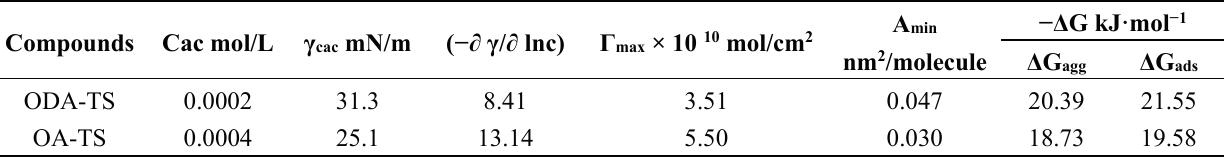
Figure 6. Optical microscope photographs of aqueous solutions of ( a ) ODA-TS (1 × 10 − 4 mmol/L); ( b ) ODA-TS (3 × 10 − 4 mmol/L); ( c ) OA-TS (1 × 10 − 4 mmol/L) and ( d ) OA-TS (3 × 10 − 4 mmol/L). Table 1. Surface properties of the ILs at the air/water